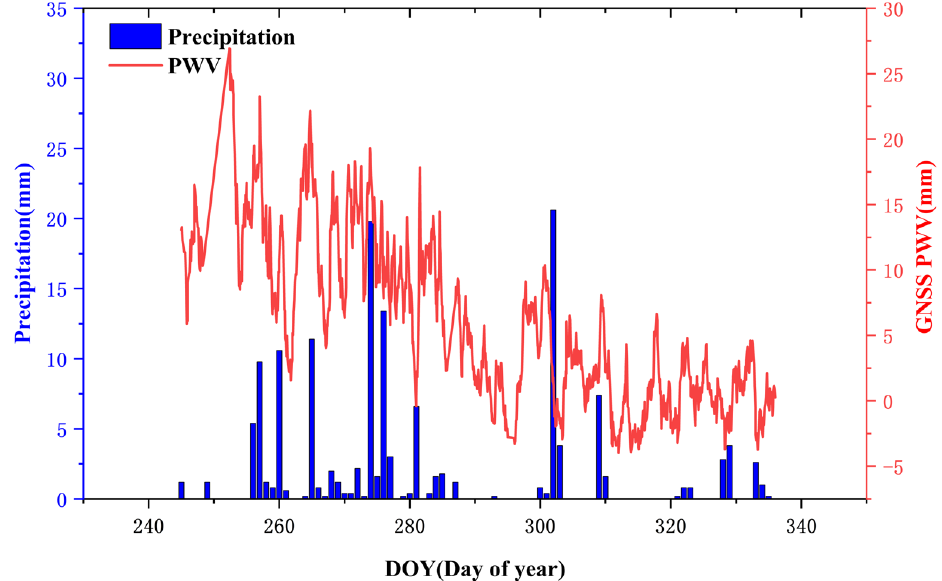
Figure 22. Relationship between PWV and rainfall estimated by GNSS receivers.